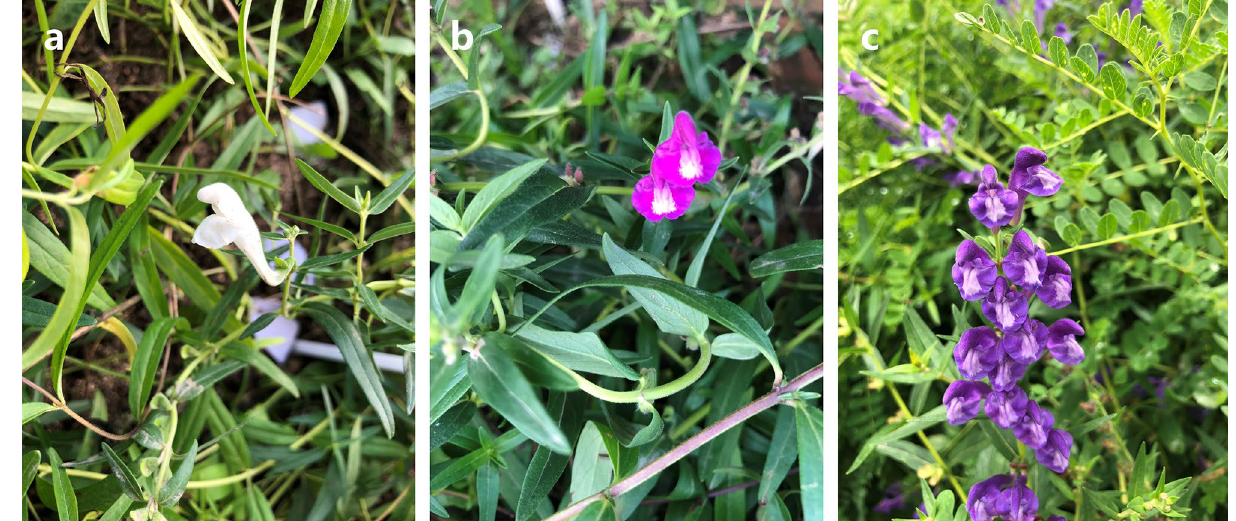
Figure 1. The phenotype of three cultivated varieties ( a : SBW, b :SBR, c :